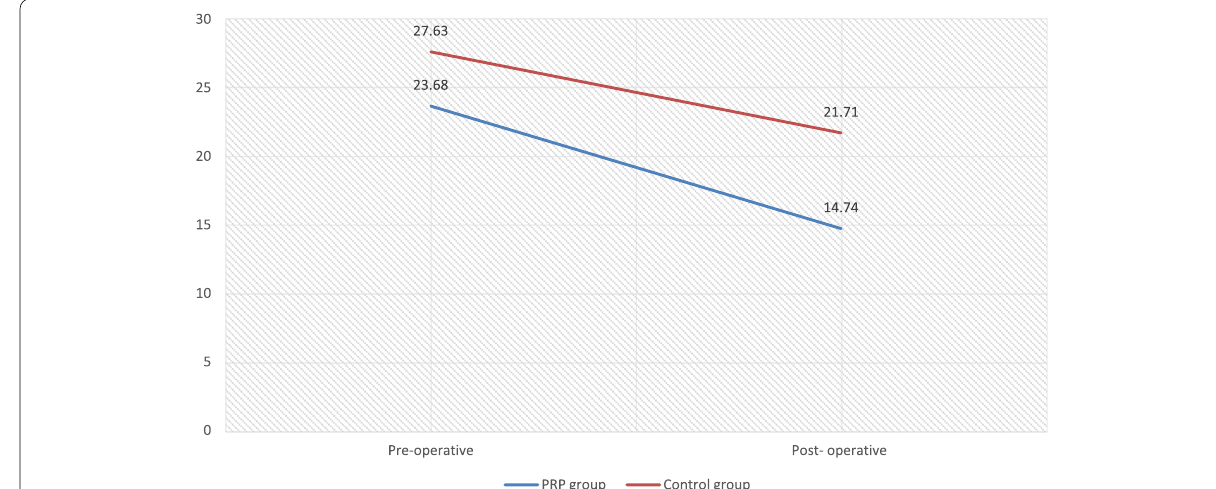
Fig. 7 Graphical representation of ABG closure in the pre-operative and post-operative period among the groups